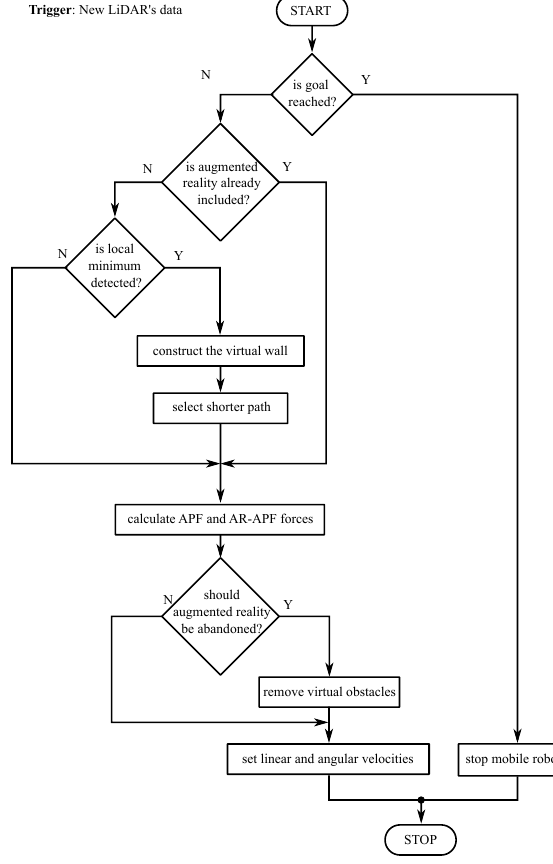
Figure 2. Detection of the local